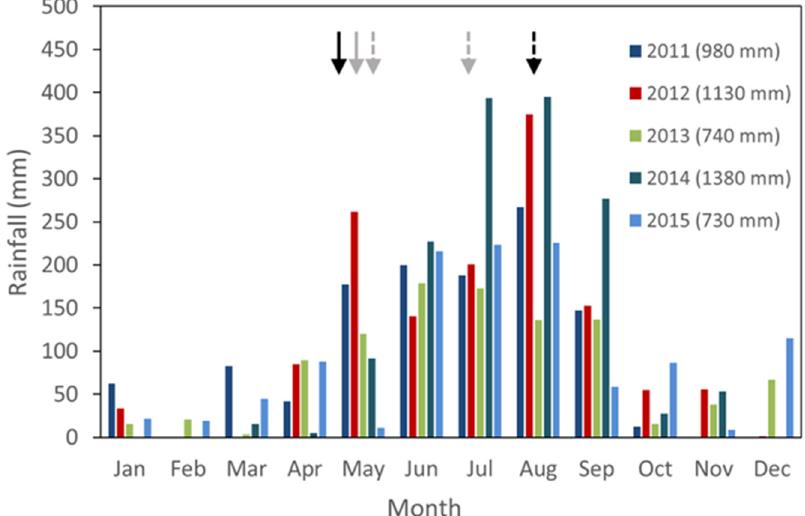
Figure 3. Monthly rainfall from 2011 to 2015 in Viengkham district and cropping seasons for maize and ricebean. Numbers in parentheses are the cumulative rainfall for the maize-growing season (May–September) in the respective years. The black solid and dotted arrows show the sowing dates of maize and ricebean, respectively, in the researcher-managed field trial. The grey solid and dotted arrows show the sowing dates of maize and ricebean, respectively, in the farmer-managed field trials.